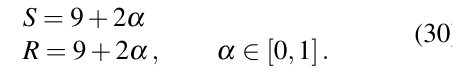
Fig. 10. Normalised cardinality distribution card ( W ) of the division of same IPVs [ 9 , 11 ] / [ 9 , 11 ] from Example